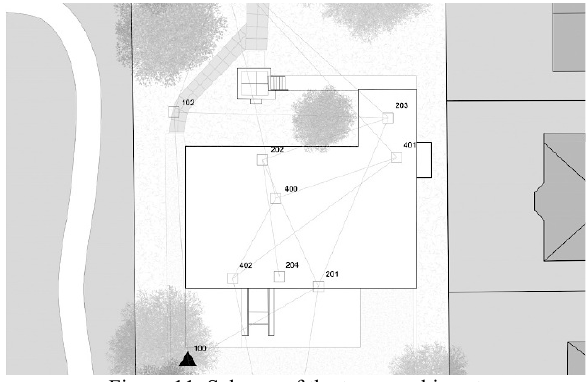
Figure 11. Scheme of the topographic